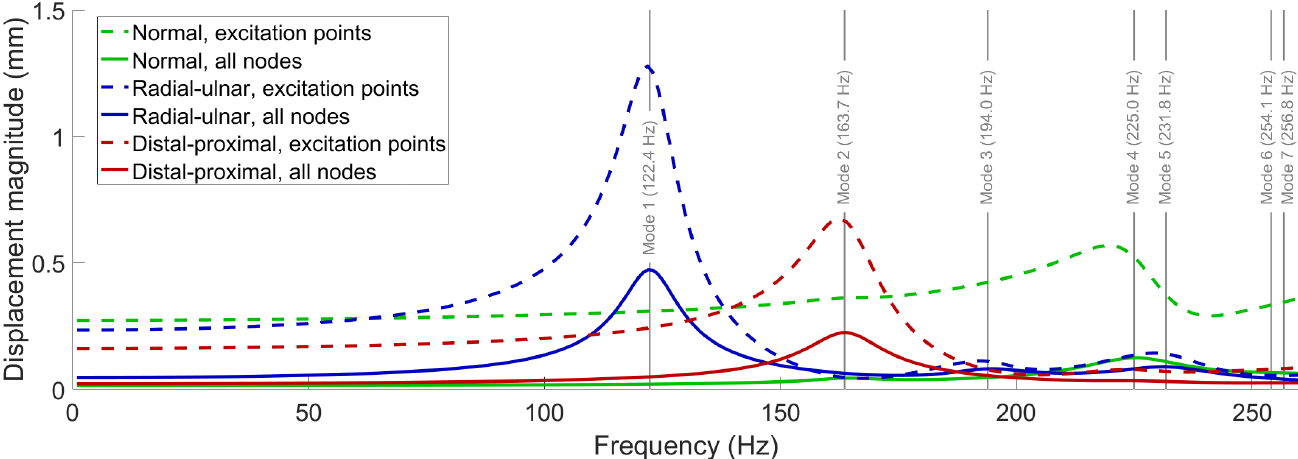
Figure 6. The FRF curves for the displacement magnitude of the fingerprint centroid under different harmonic loads applied in the normal, radial–ulnar, and distal–proximal directions. For each result, the dashed lines show the average displacement of the nine excitation points, and the solid lines show the average displacement of all moving nodes in the model. The previously obtained natural frequencies are marked with gray vertical lines to facilitate the interpretation of the FRF